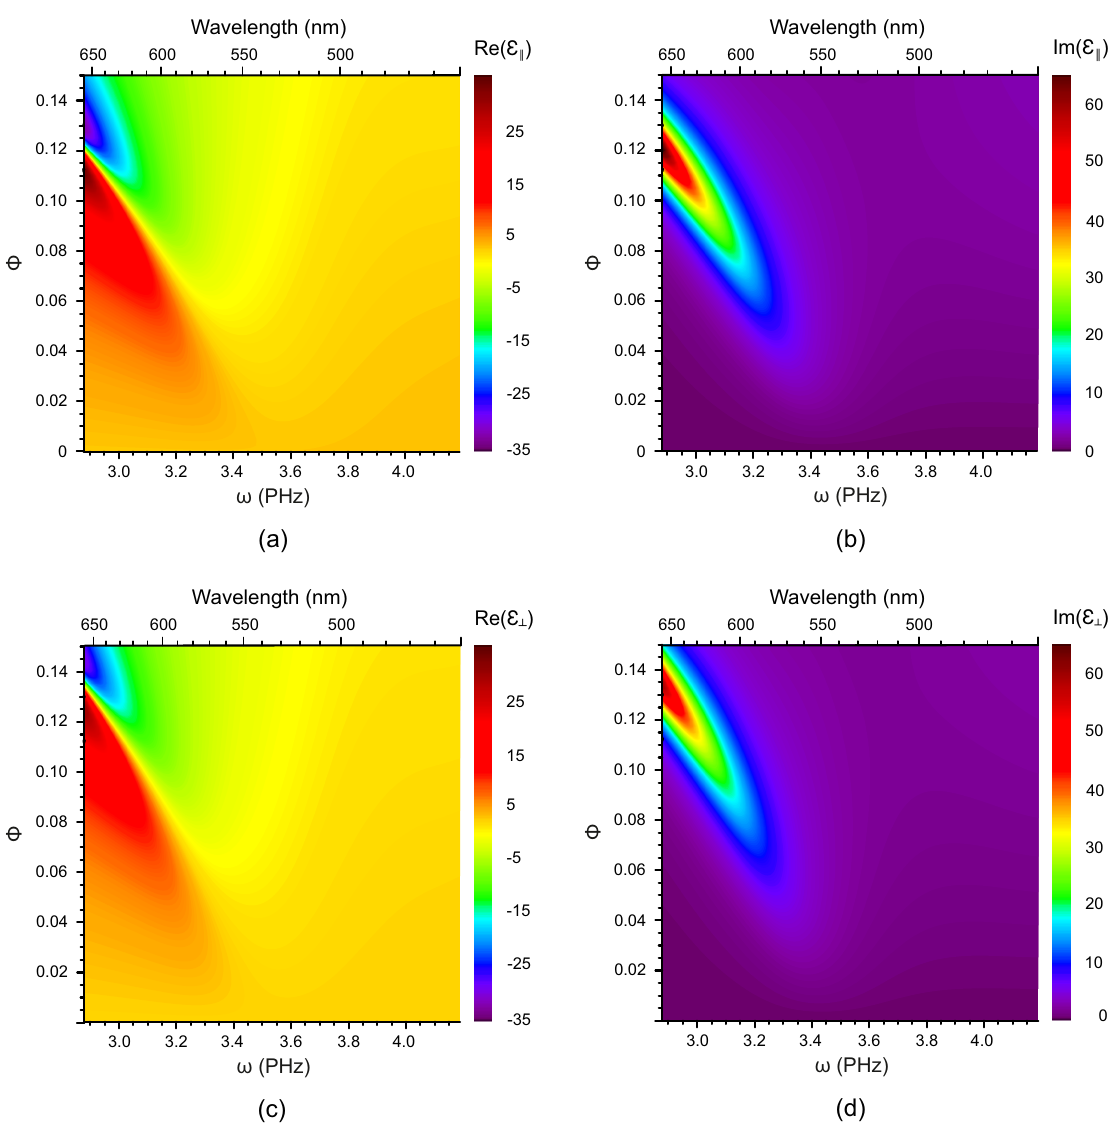
Figure 2. The dependence of Re ( ε (cid:107) ) ( a ), Im ( ε (cid:107) ) ( b ), Re ( ε ⊥ ) ( c ) and Im ( ε ⊥ ) ( d ) of the nematic nanocomposite (host 5 CB plus AuNPs) on the volume fraction of AuNPs φ and cyclic frequency ω